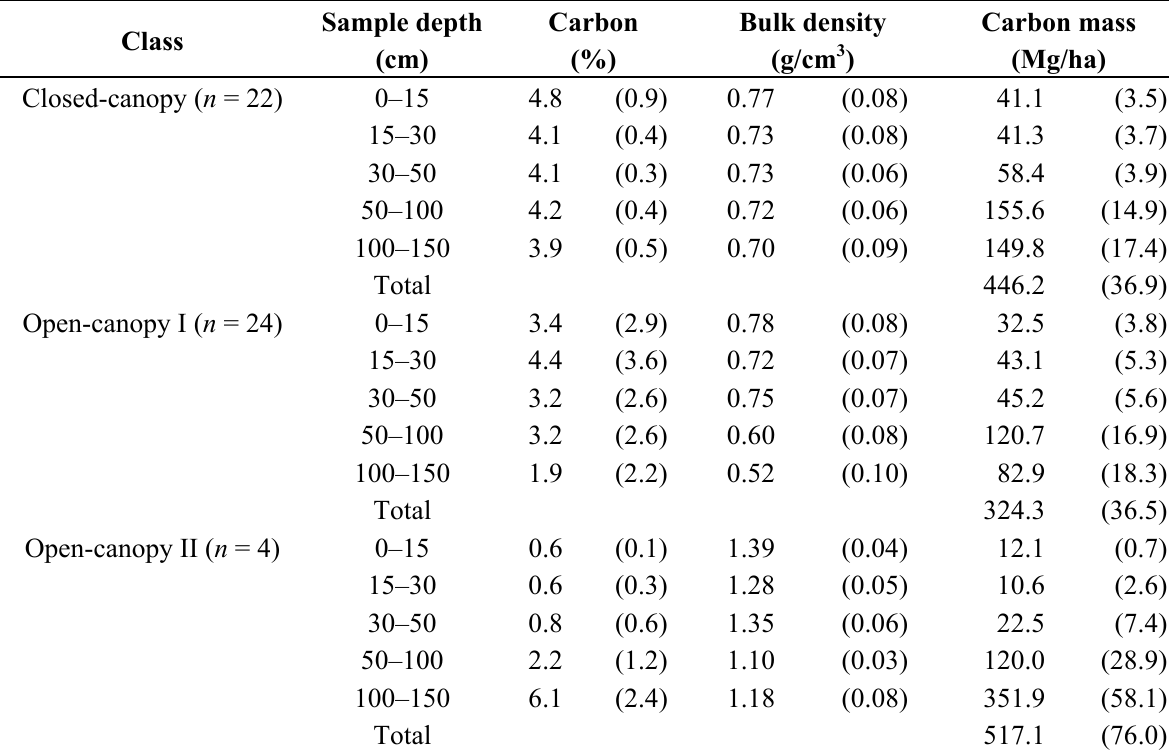
Table 6. Average hectare (ha)-level carbon (%), bulk density (g/cm 3 ) and carbon mass (Mg/ha) estimates ±1 standard error (in brackets). Estimates are partitioned by mapped mangrove class and soil depth strata. N corresponds with the number of plots per class